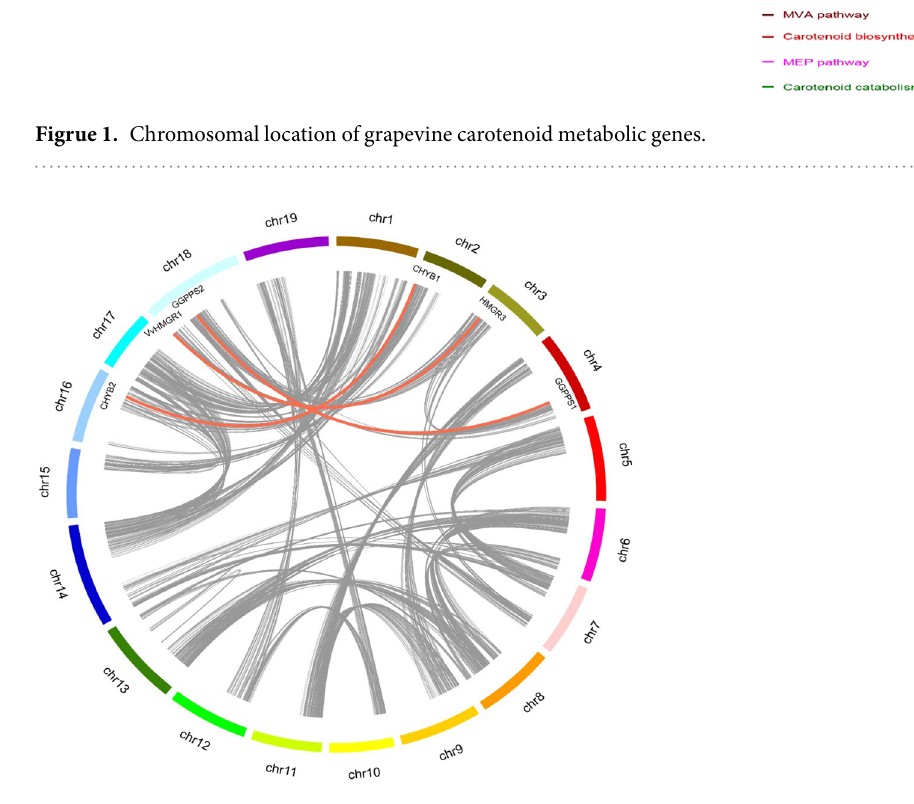
Figrue 2. Synteny analysis of grapevine carotenoid metabolic genes. Gray lines indicate all synteny blocks in the grapevine genome, whereas the red lines suggest duplicated gene